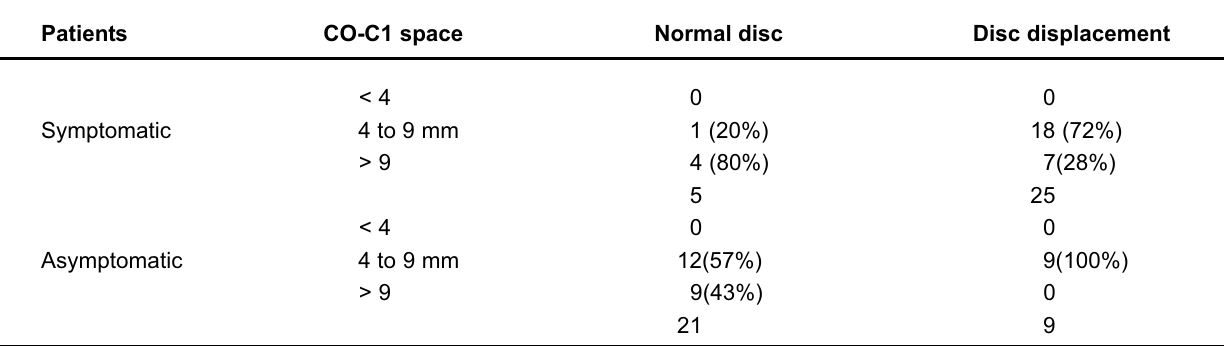
Fisher’s exact test (p<0.05); symptomatic (p=0.04) and asymptomatic TABLE 2- Distribution and classification of the TMJs of symptomatic and asymptomatic individuals, with and without articular disc displacement, in relation to the values referring to the C1-C2 space